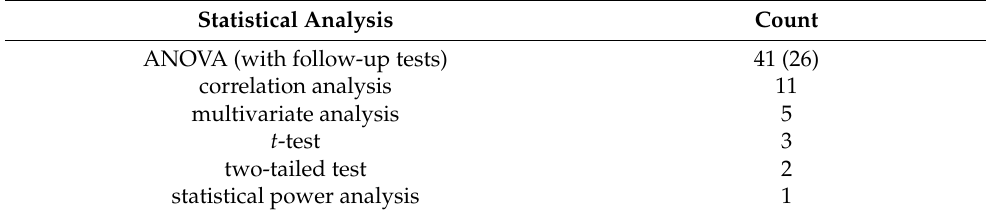
Table 6. Statistical analysis for selected